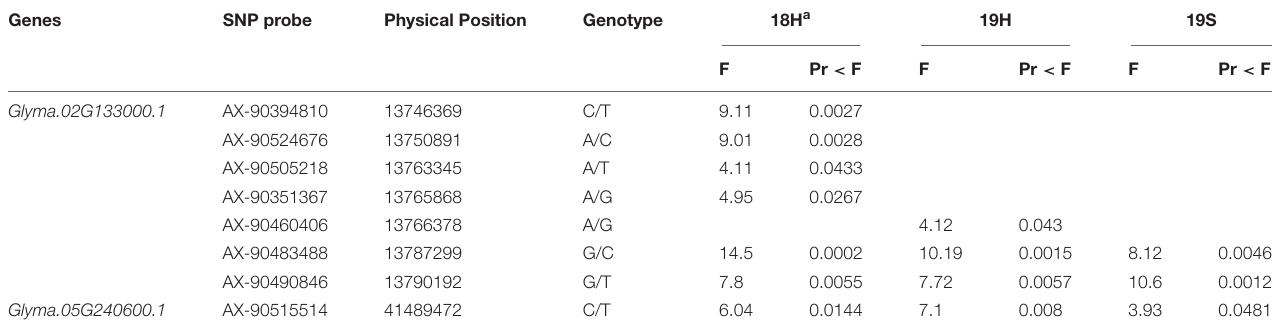
TABLE 6 | SNPs markers associated with plant height near Glyma.02G133000 and Glyma.05G240600.1 . Genes SNP